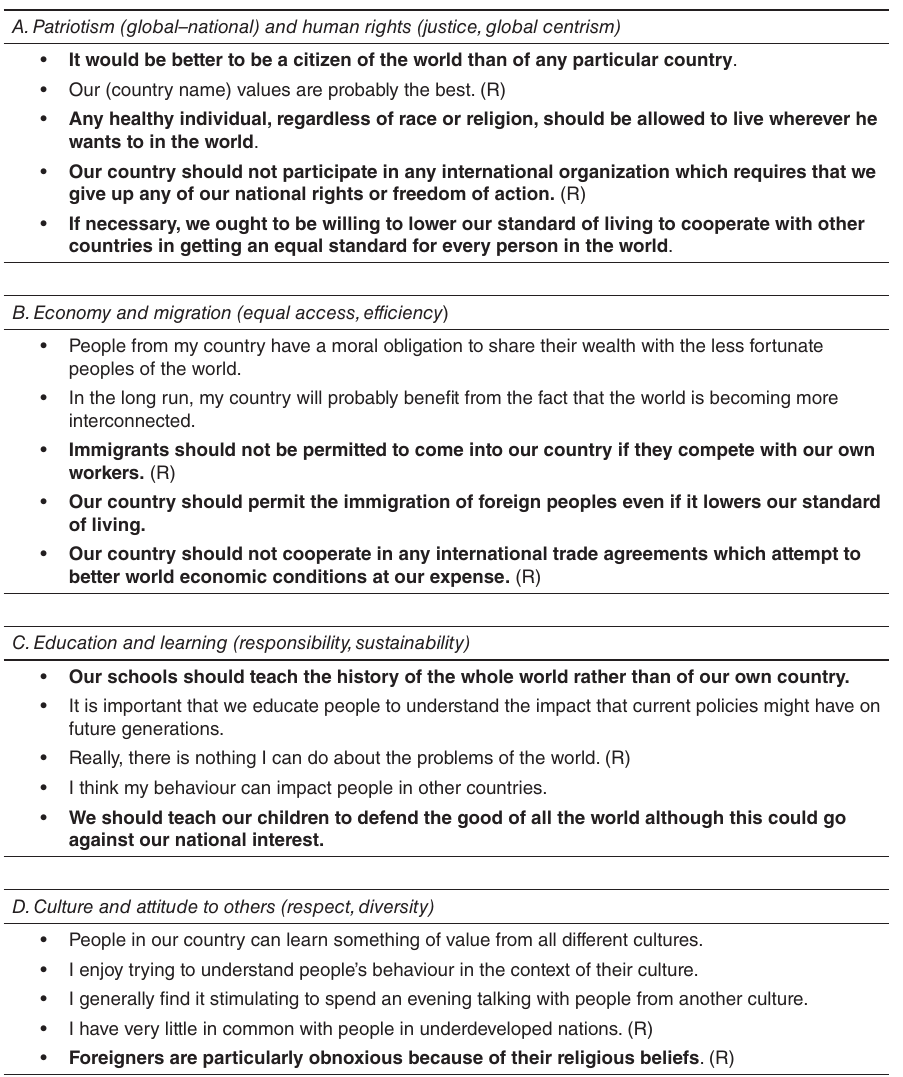
Table 1: Questionnaire statements to assess